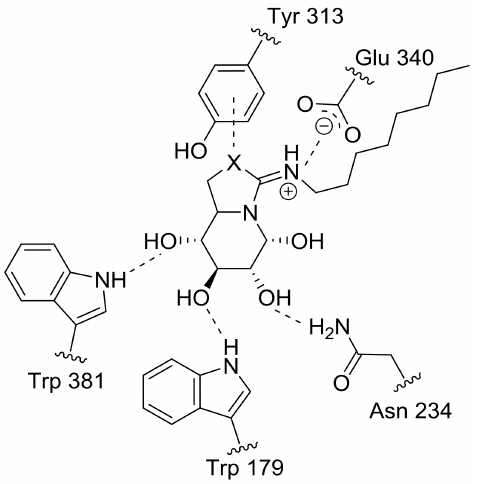
Figure 3. Salt bridge and hydrogen-bonding interactions of compounds 1 (X = O) and 2 (X = S) in the active site of human GCase as evidenced in the corresponding crystal structures (PDB codes 2XWD